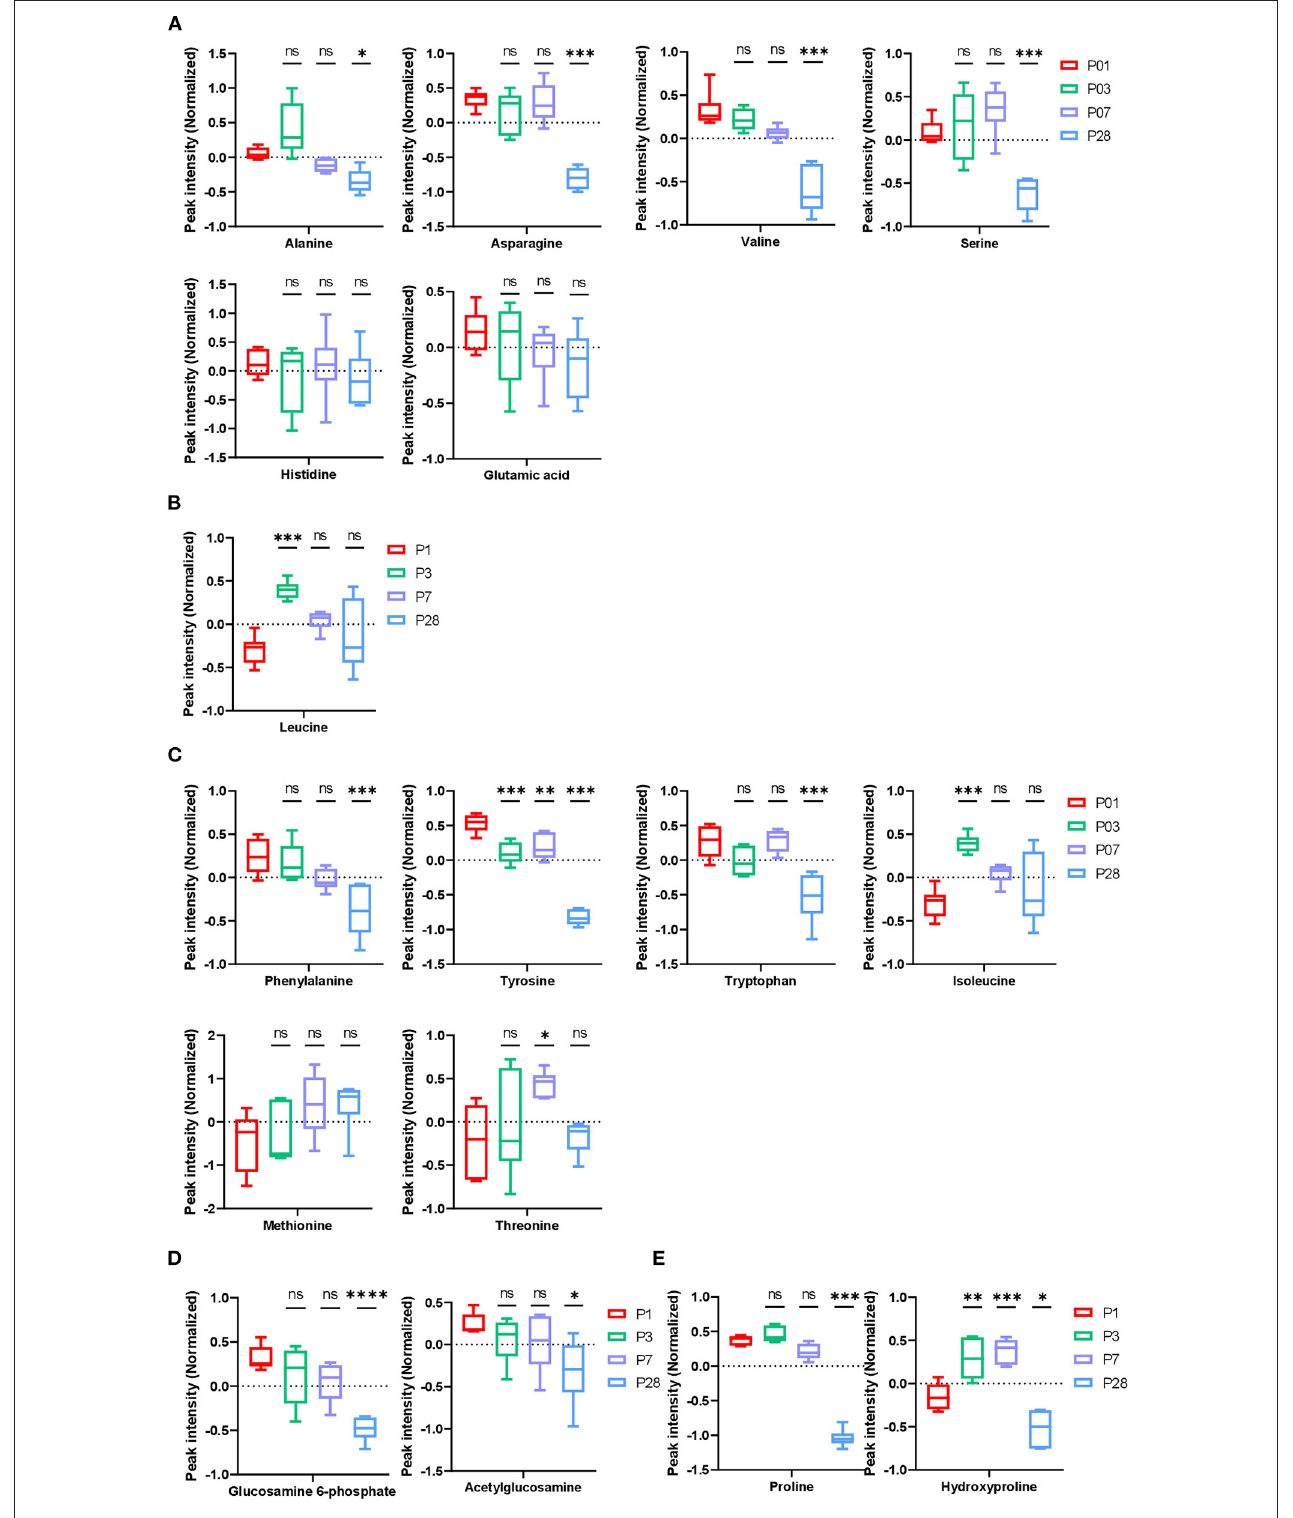
FIGURE 3 | Amino acid and collagen metabolism in neonatal pig hearts. (A–D) Metabolic profile of glucogenic amino acids (A) , ketogenic amino acids (B) , glucogenic/ ketogenic amino acids (C) , and glucosamine 6-phosphate (D) . (E) Metabolites in the collagen synthesis pathway. * p < 0.05, ** p < 0.01, *** p < 0.001, **** p < 0.0001, one-way ANOVA with Tukey’s Honestly Significant Difference Test. n = 6 hearts per age.